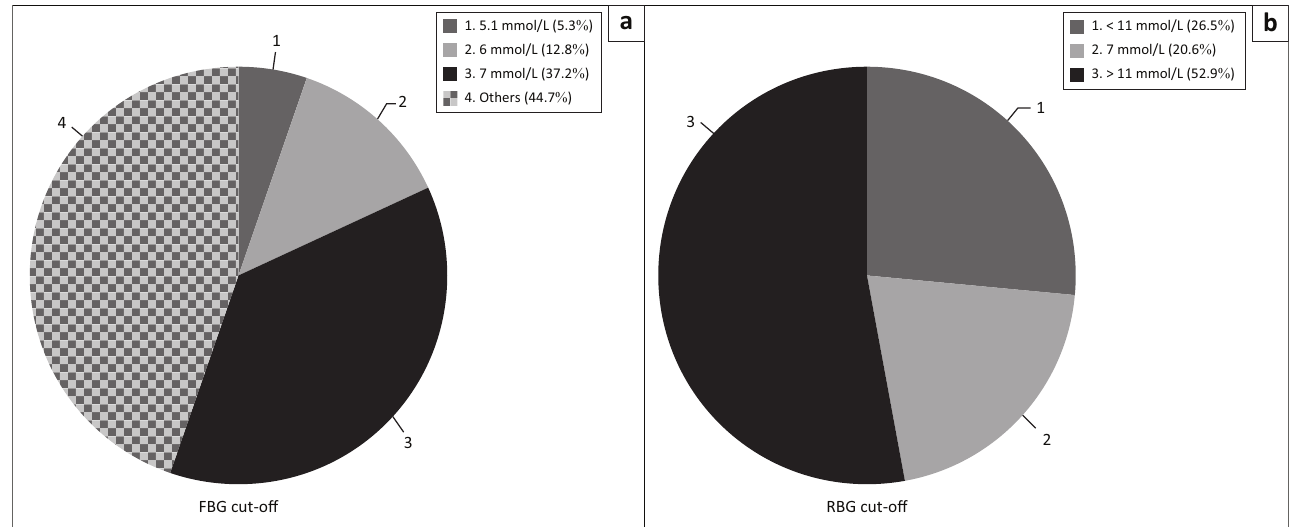
FIGURE 3: Threshold values of fasting blood glucose and random blood glucose for diagnosing gestational diabetes mellitus among antenatal healthcare providers in healthcare facilities in Jos North, Plateau state, Nigeria, August 2019 to September 2019. (a) fasting blood glucose threshold (b) random blood